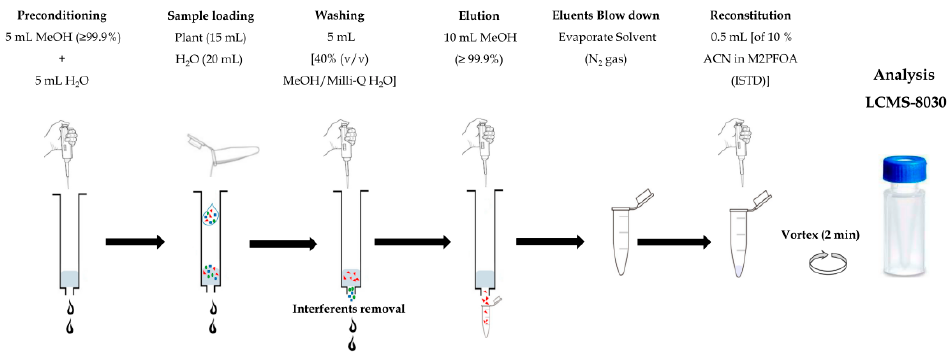
Figure 1. Schema for solid phase extraction (SPE) of water and plant samples.